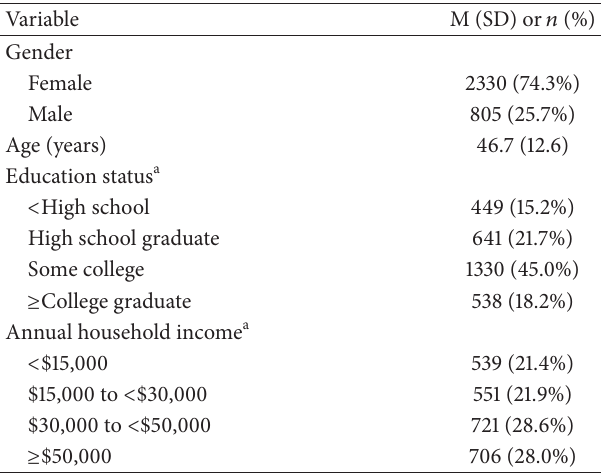
Table 1: Characteristics of SDPI-DP